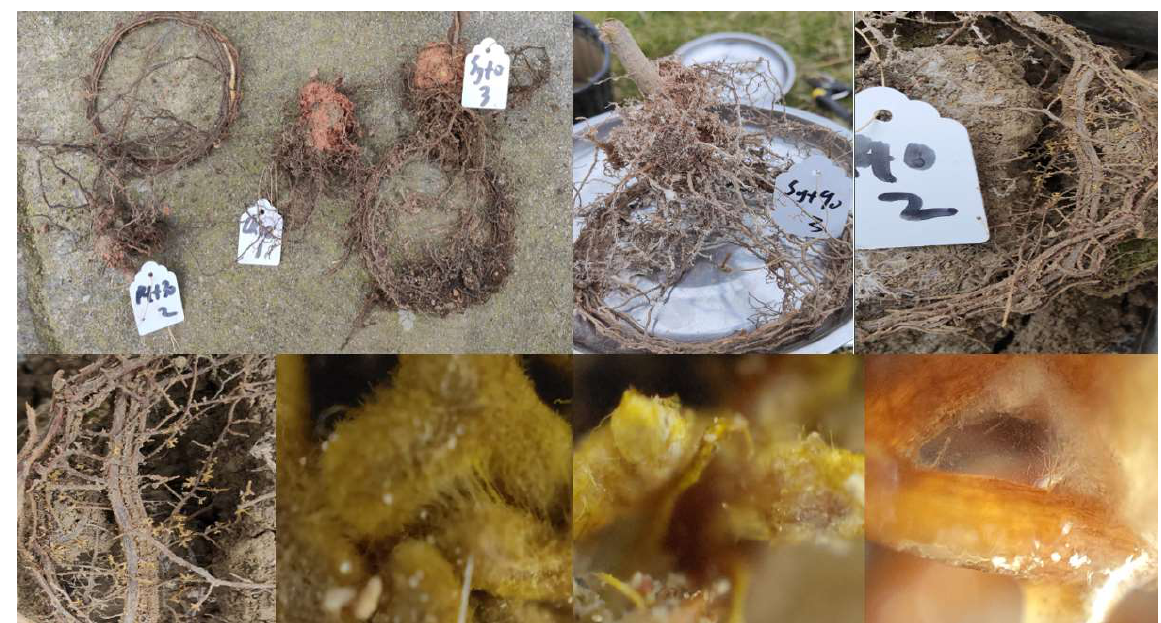
Figure 1. EMF formed with Pinus massoniana seedlings.